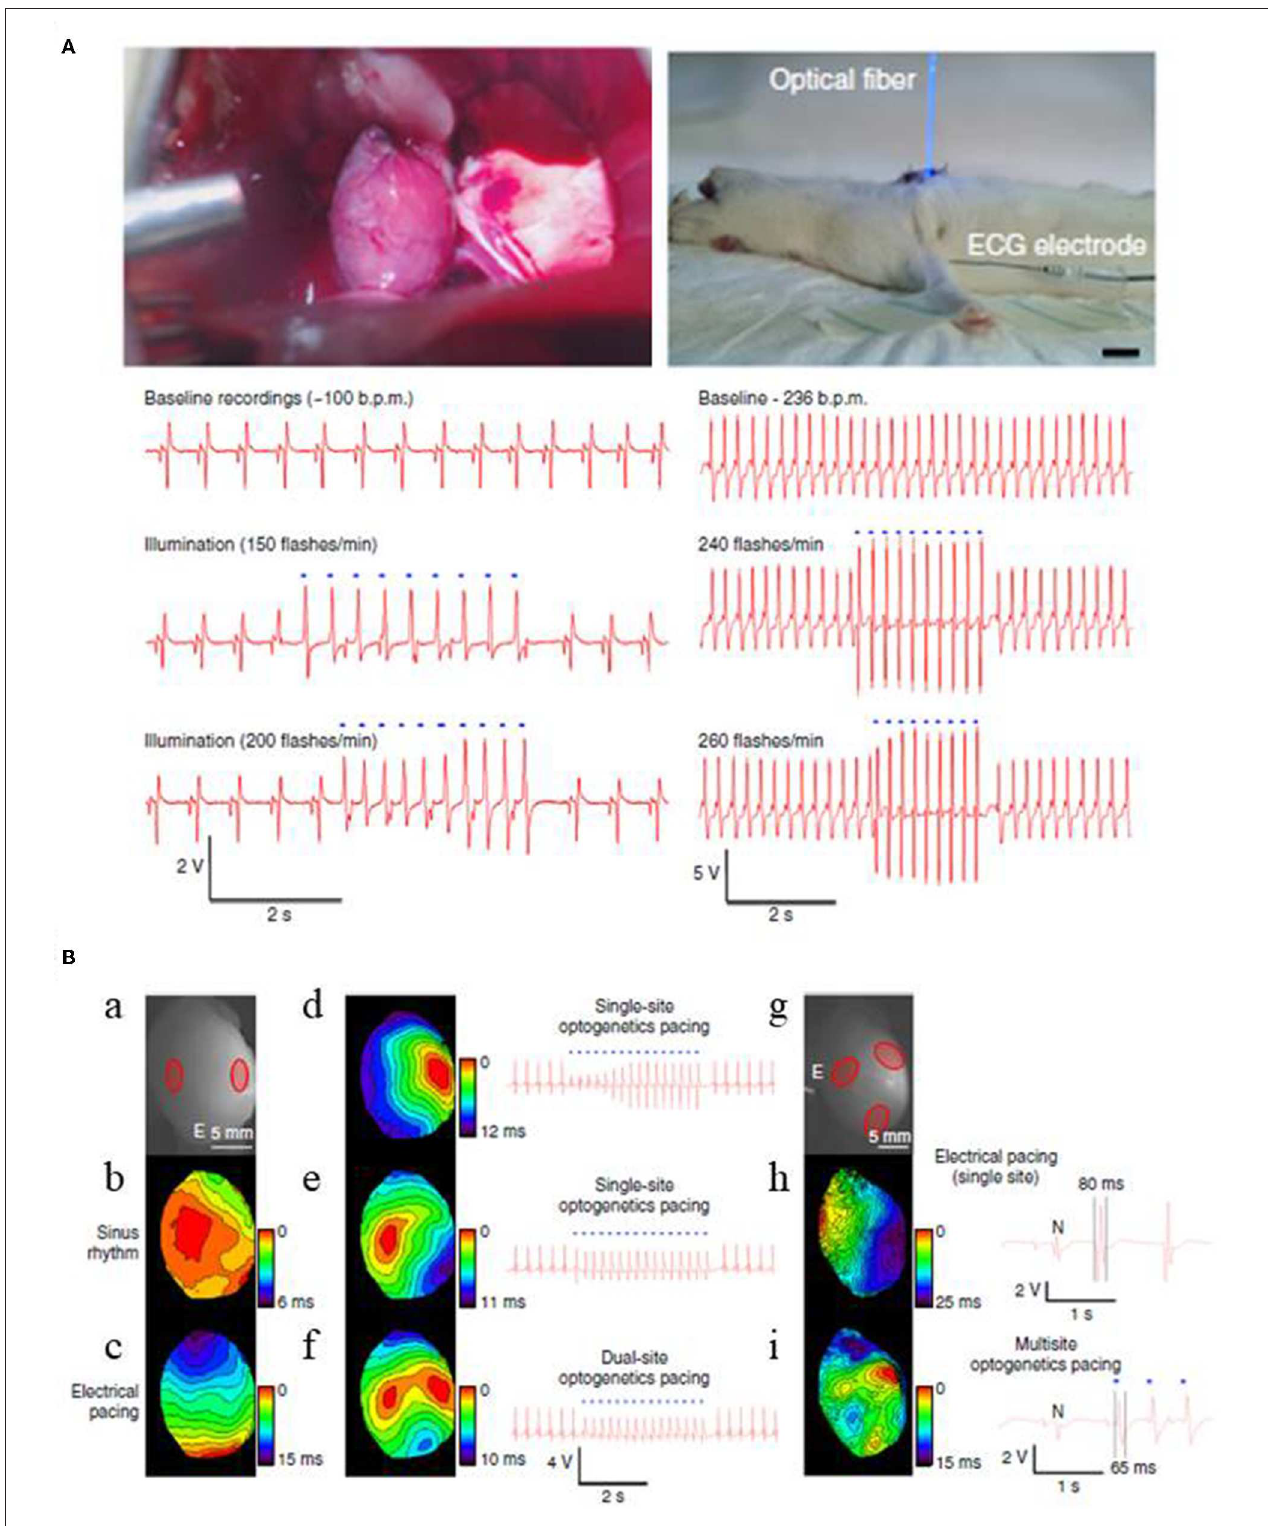
FIGURE 6 | Optogenetic pacing of rat hearts in an open chest (left) and a closed chest (right) configurations (A) . Apical expression of ChR2 was obtained via intra-myocardial delivery of transgene-carrying AAV-9 vector in the apex of rat hearts. Two weeks after the transgene delivery photosensitive hearts were illuminated